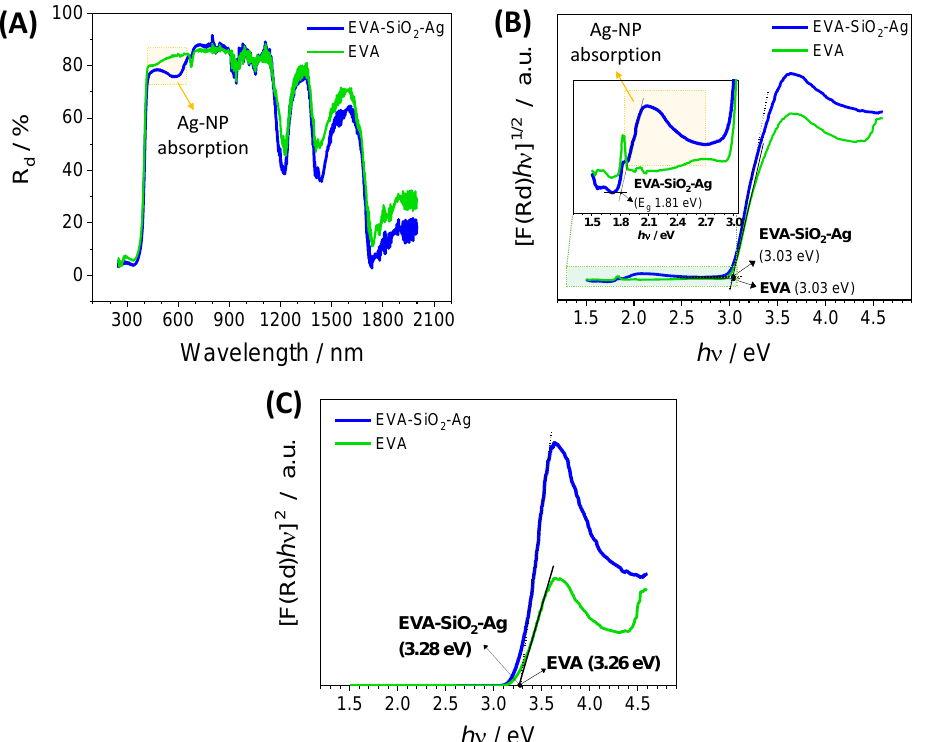
Figure 5. ( A ) Diffuse reflectance spectra, ( B ) indirect interband transition and ( C ) direct interband transition of pure EVA and EVA-SiO 2 -Ag.